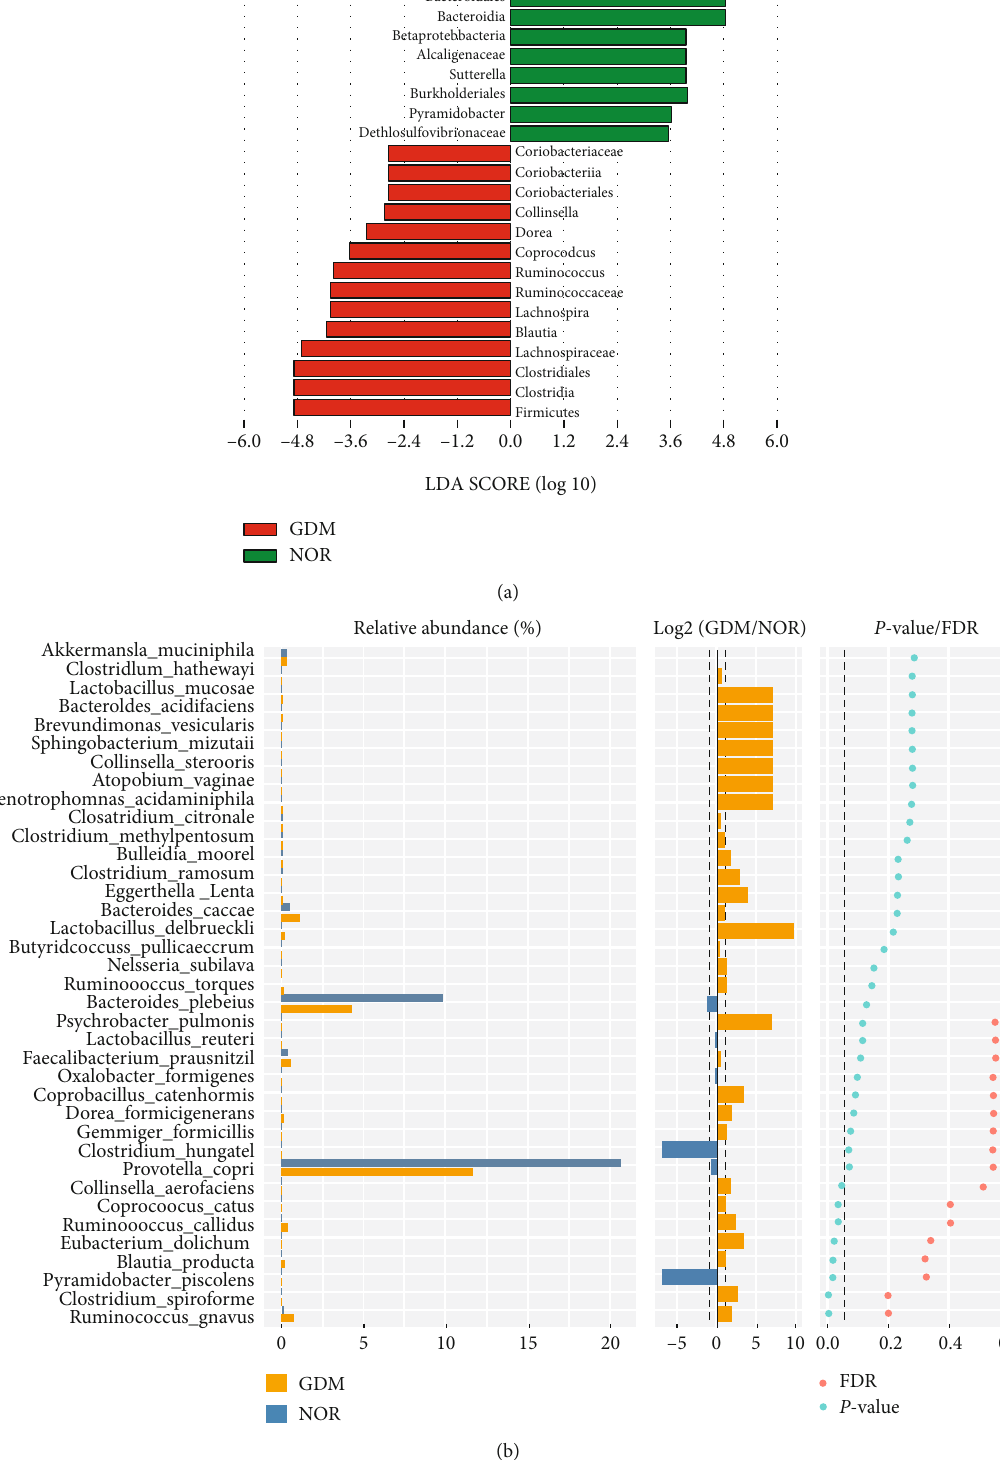
Figure 4: Analysis of the di ff erences in intestinal fl ora species between the di ff erent groups. (a) LDA analysis of the NOR and GDM groups; (b) the NOR and GDM groups di ff erence analysis of the Wilcoxon rank-sum test at the species